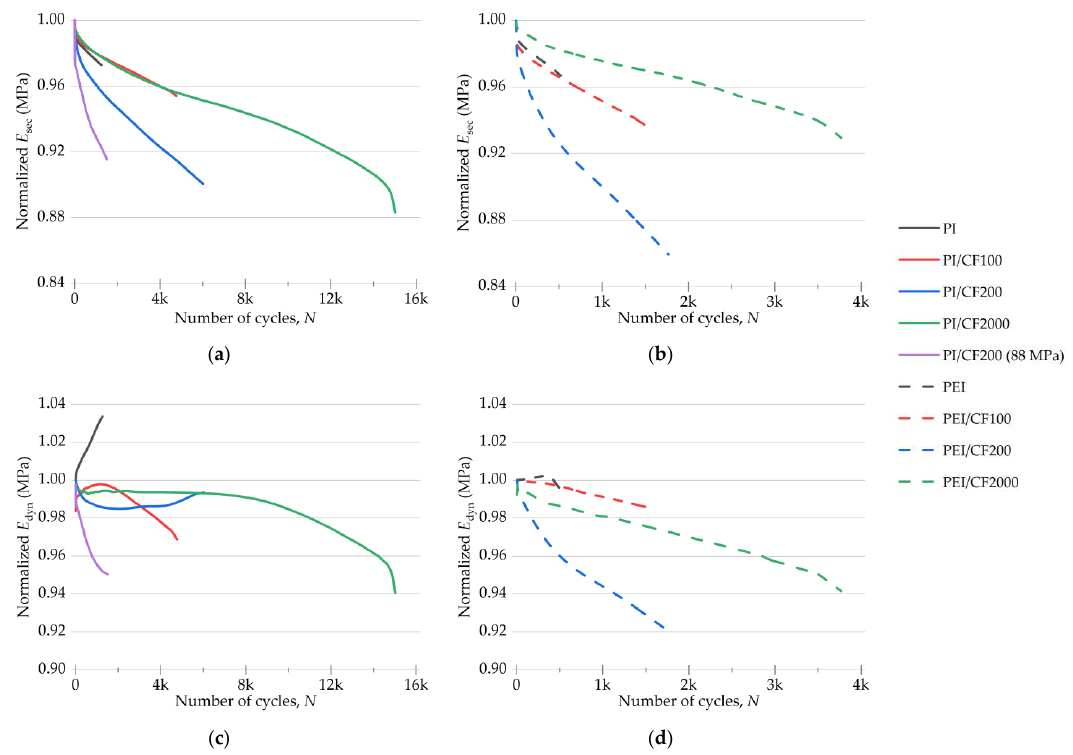
Figure 9. The changes in E sec secant ( a , b ) and E dyn dynamic ( c , d ) moduli for the PI- and PEI-based composites under cyclic loads; normalization was made over the initial values.